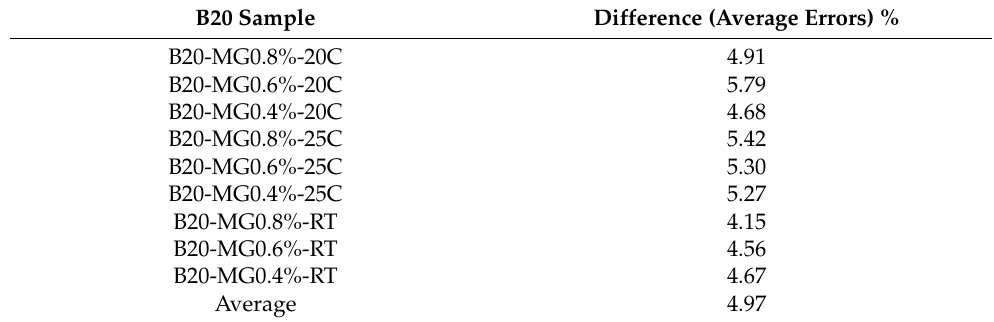
Table 10. The difference (averaged errors) between the pressure drop values from the modified FBT test and those from the simulation